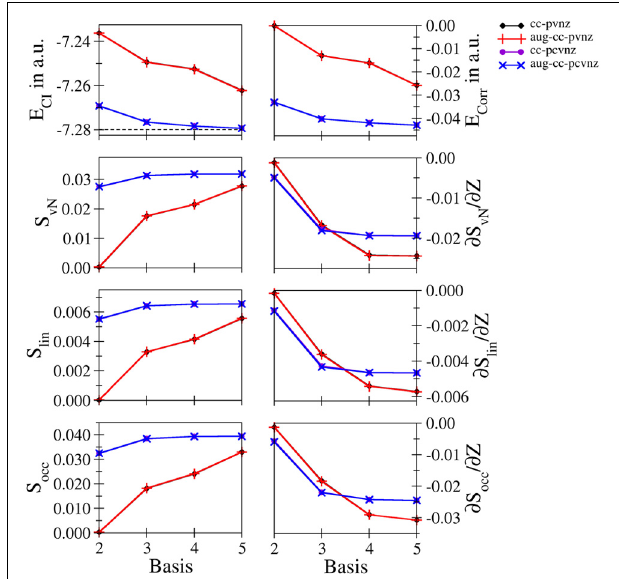
FIGURE 3 | Total and correlation energy E CI and E corr in atomic units; von Neumann S vN , linear S lin and occupation number S occ entropies and their derivative with respect to the nucleic charge Z obtained for Li + at the FCI level using different basis sets.